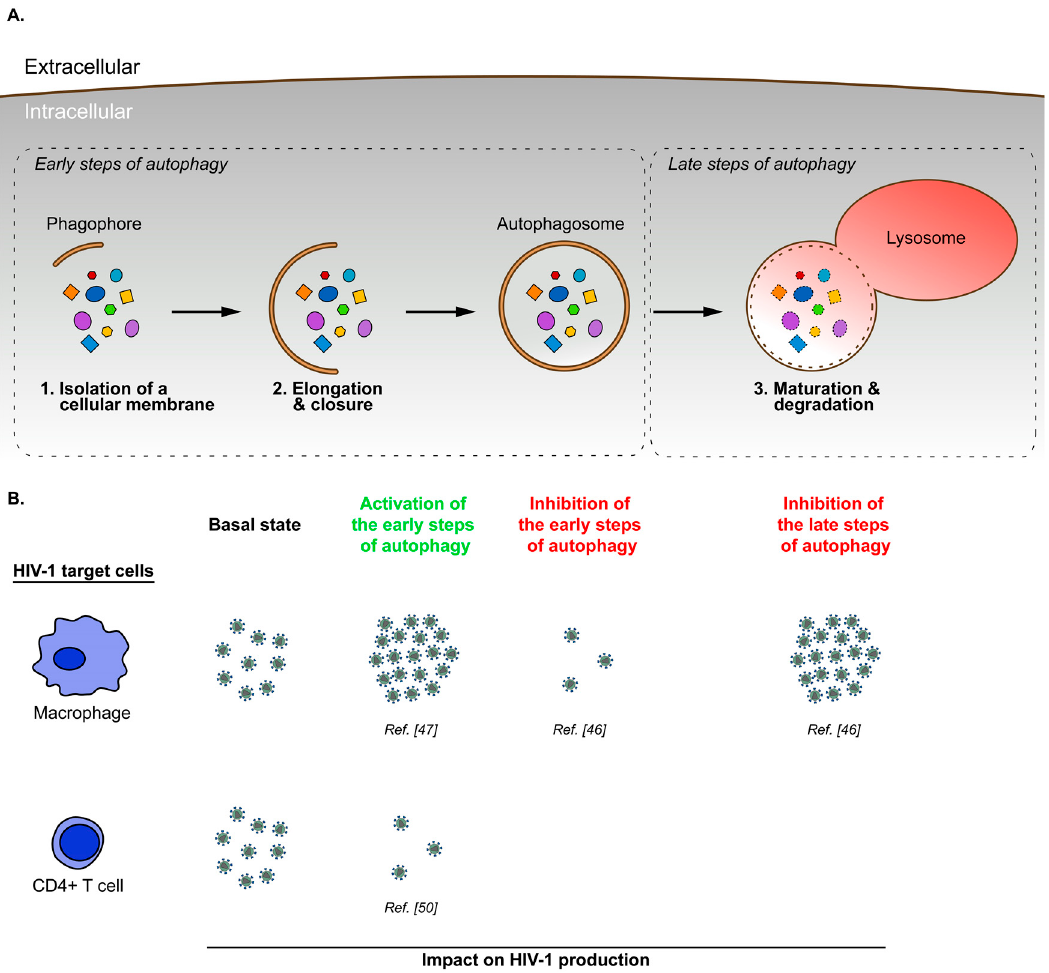
Figure 2. The interplay between autophagy and HIV-1 production in cell type specific manner. ( A ) Canonical autophagy mechanism can be decomposed into early steps, corresponding to the isolation, elongation and closure of a cellular membrane (phagophore) to form a double-layered membrane vesicle enclosing cytoplasmic materials (autophagosome); and late steps, corresponding to the autophagosome-lysosome fusion/maturation and the degradation of autophagosomal content; ( B ) In HIV-1 infected cells, activation or inhibition of early and late steps of autophagy process modulate virus production in a cell-type-specific manner. While induction of autophagy dramatically impairs HIV-1 production in CD4+ T cells, activation of early steps of autophagy is indispensable for the optimal production of viruses in macrophages. Conversely, blockage of late steps of autophagy favors an efficient HIV-1 production in macrophages.